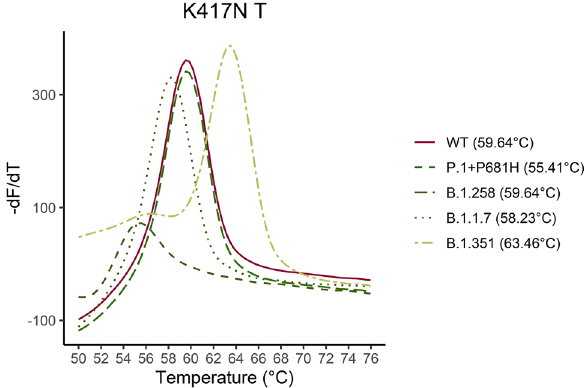
Figure 7. Five samples for the P.1 + P681H, B.1.351, B.1.1.7, B.1.258 and WT were analyzed. The melting curve of the five samples are illustrated for the K417N/T assay. As it is shown in the graph the K417N mutation can be distinguished by approximately 4 °C from the WT sequence and the K417T mutation can be distinguished 4 °C below the WT